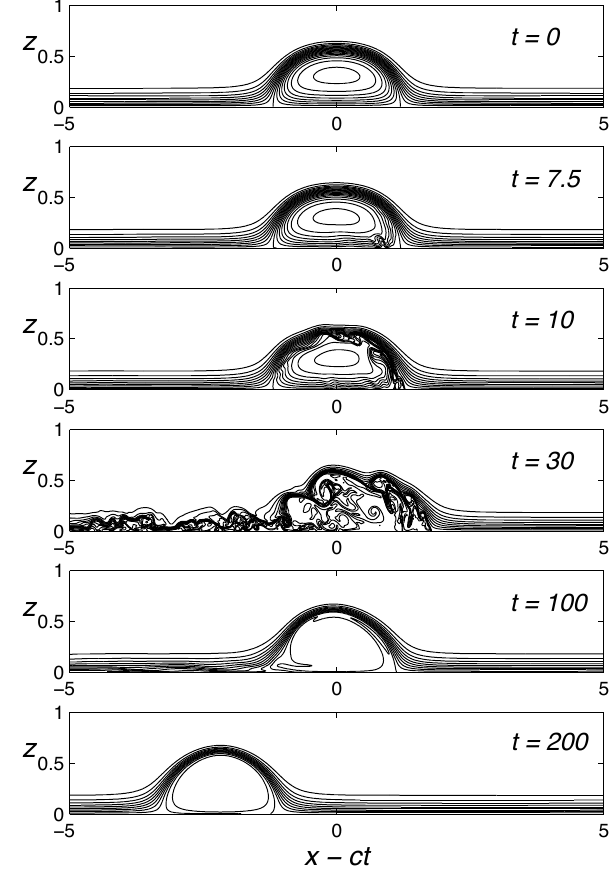
Fig. 3. Evolution of an extended- ¯ s DJL solution for λ = 8 and c = 0 . 58. Contours of s in intervals of 0.1 are plotted.